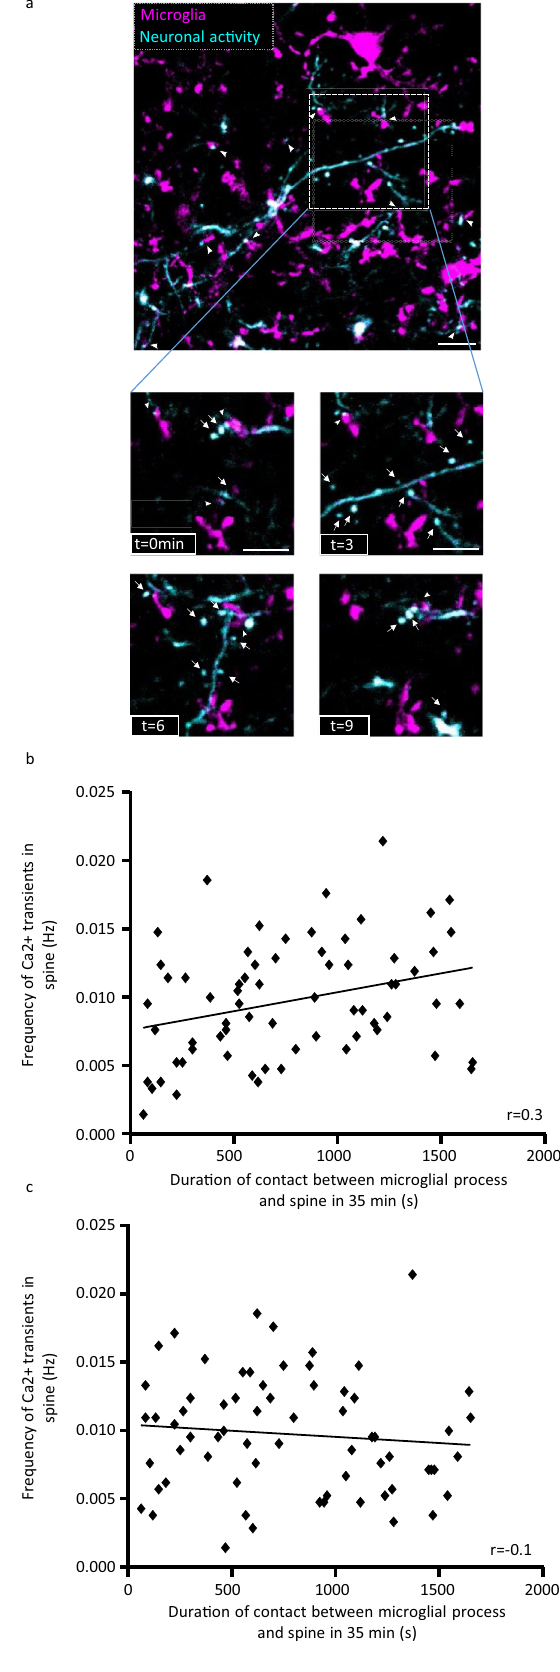
Fig. 2 | Microglia contact spines in an activity-dependent manner. a Simultaneous imaging of microglial processes (magenta, arrow) and neuronal GCaMP6 expression (cyan) in the L1 of the primary somatosensory cortex. The arrowheads indicate contacts between microglial processes and spines. The dynamic interactions between microglial processes and spines are shown in a smaller FOV (delimited by the white square) over a 10-min period. Examples of microglial processes interacting with spines are indicated with the white arrow- heads, whereasspines not incontactwith microglia arepointed withwhite arrows. The brightness and contrast were adjusted for visualization purposes. One repre- sentativeimagewithtenreplicates. b CorrelationbetweenCa 2+ spinefrequencyand the duration of microglia-spine contact ( n =68 spines from fi ve mice, Pearson ’ s correlation test, two-tailed, p =0.012). c Correlation between spine activity and duration of microglia-spine contact for a random data set ( n =68 spines from fi ve mice, Pearson ’ s correlation test, two-tailed, p =0.42). All data are represented as mean±SEM. Source data are provided as a Source Data fi le for b , c